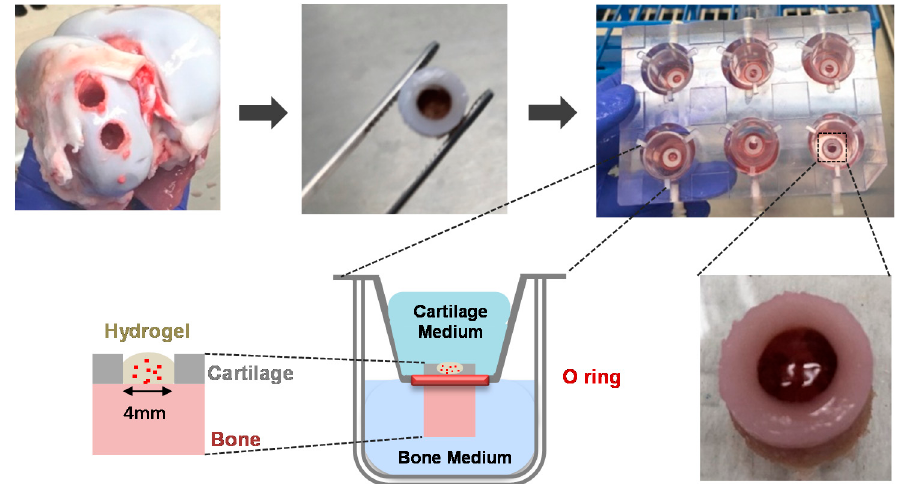
Figure 2. Ex vivo osteochondral platform: isolation of osteochondral explants; formation of cartilage defects; mounting of the osteochondral explants; filling of osteochondral explants with chondrocyte-laden methacrylated hyaluronic acid MeHA hydrogels.